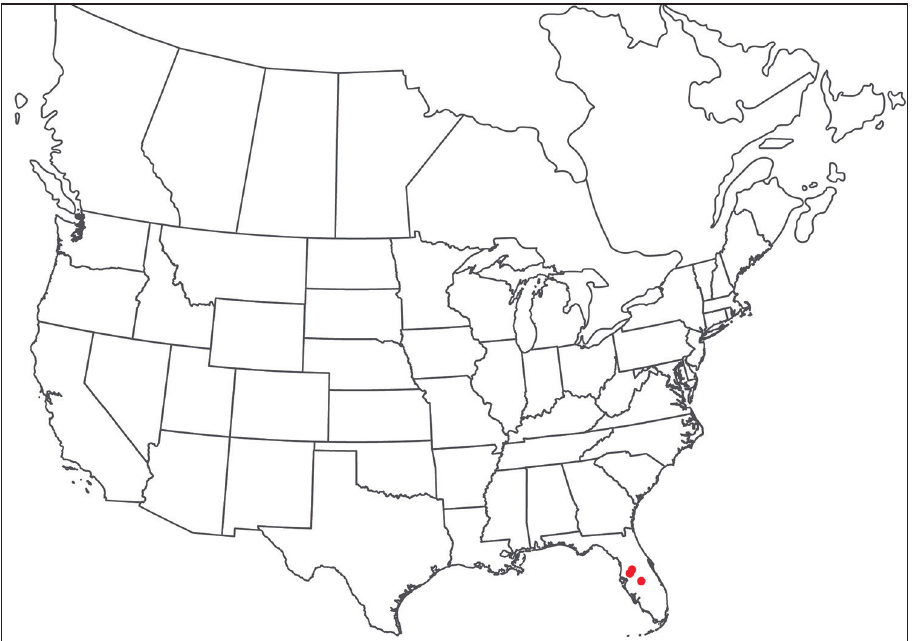
Figure 105. Torrenticola ivyae sp. n.